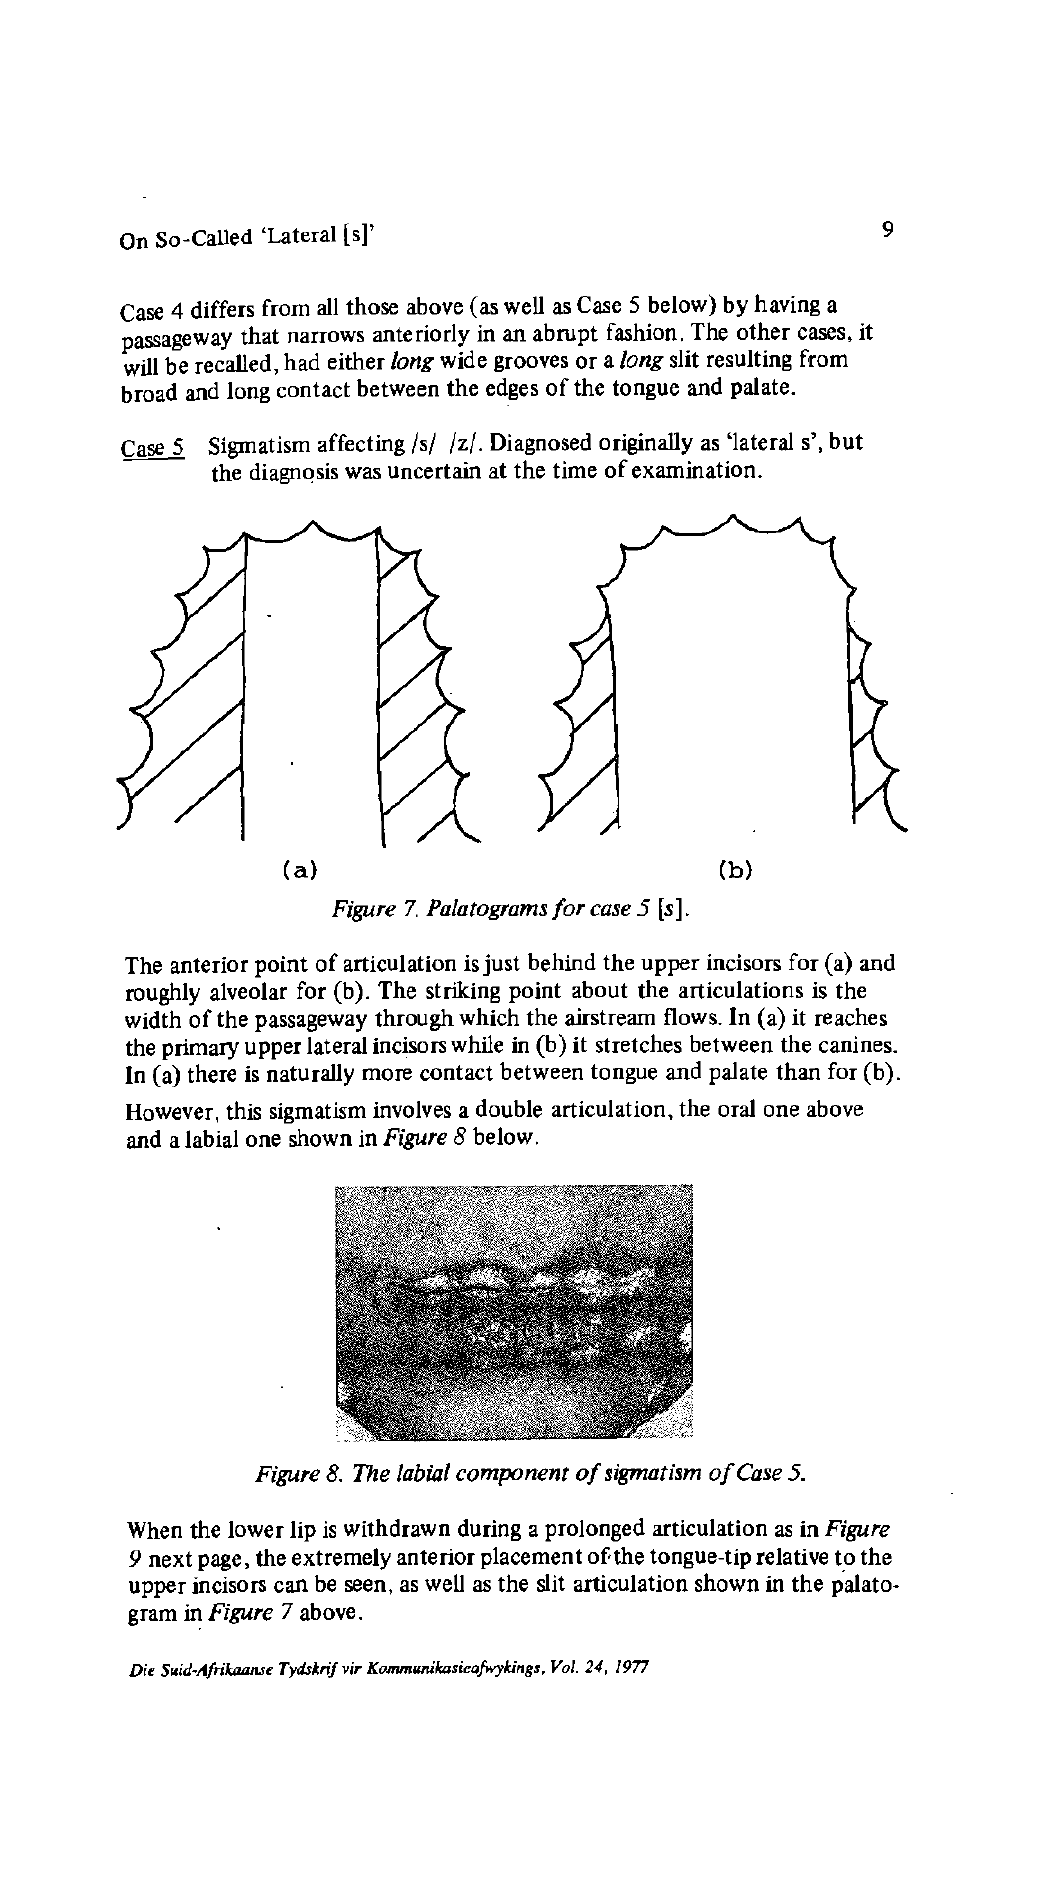
Figure 8. The labial component of sigmatism of Case